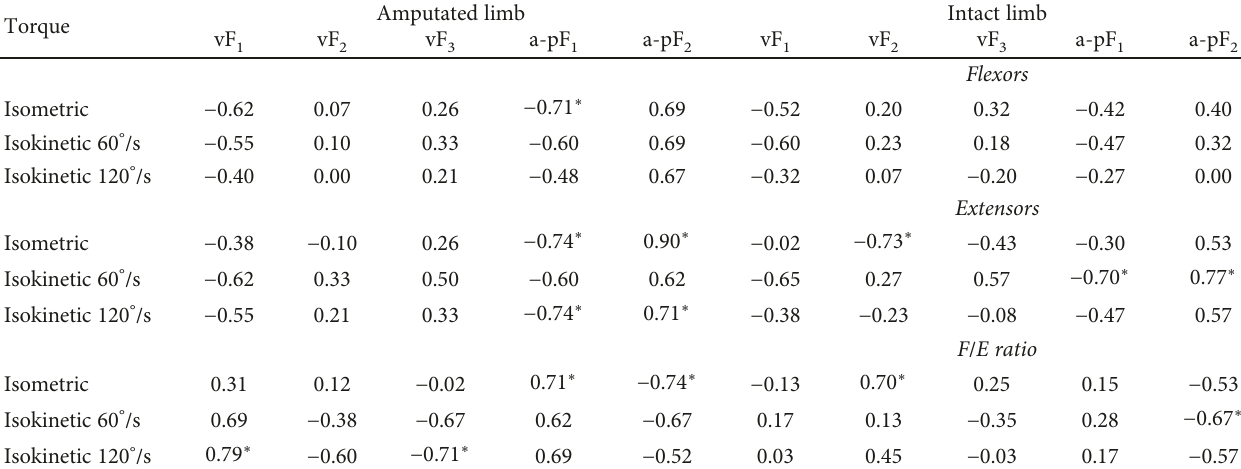
Table 4: Correlation coe ffi cients between the symmetry index for ground reaction forces and hip fl exor and extensor muscle peak torques. Torque